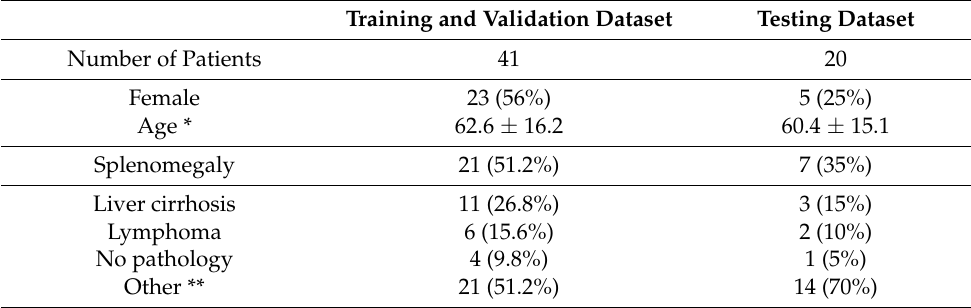
Table 1. Characteristics of the In-house